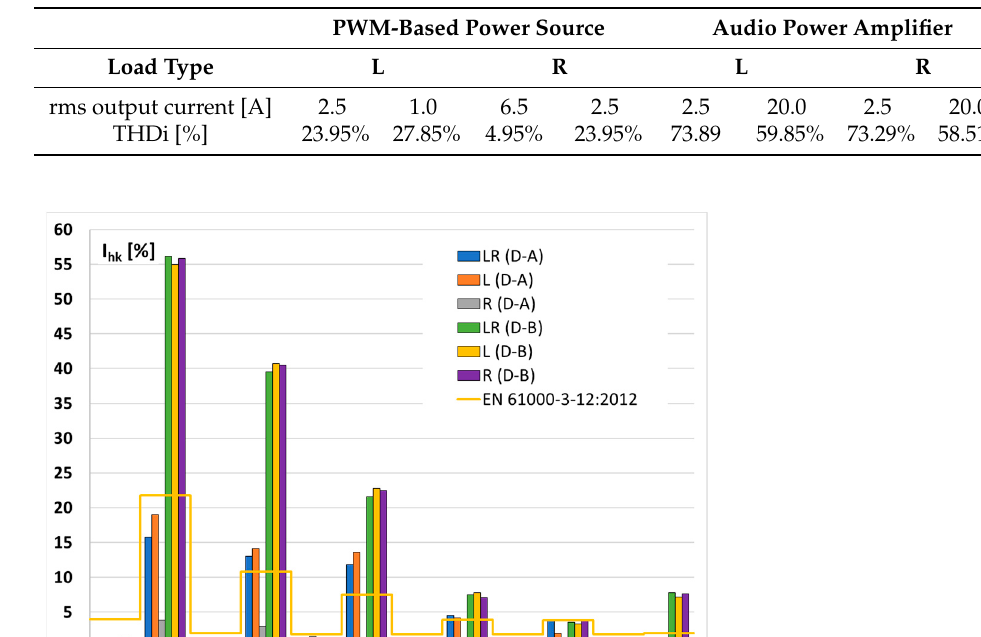
Table 1. The values of THDi factors of supply currents of tested PWM-based power source and audio power amplifier.